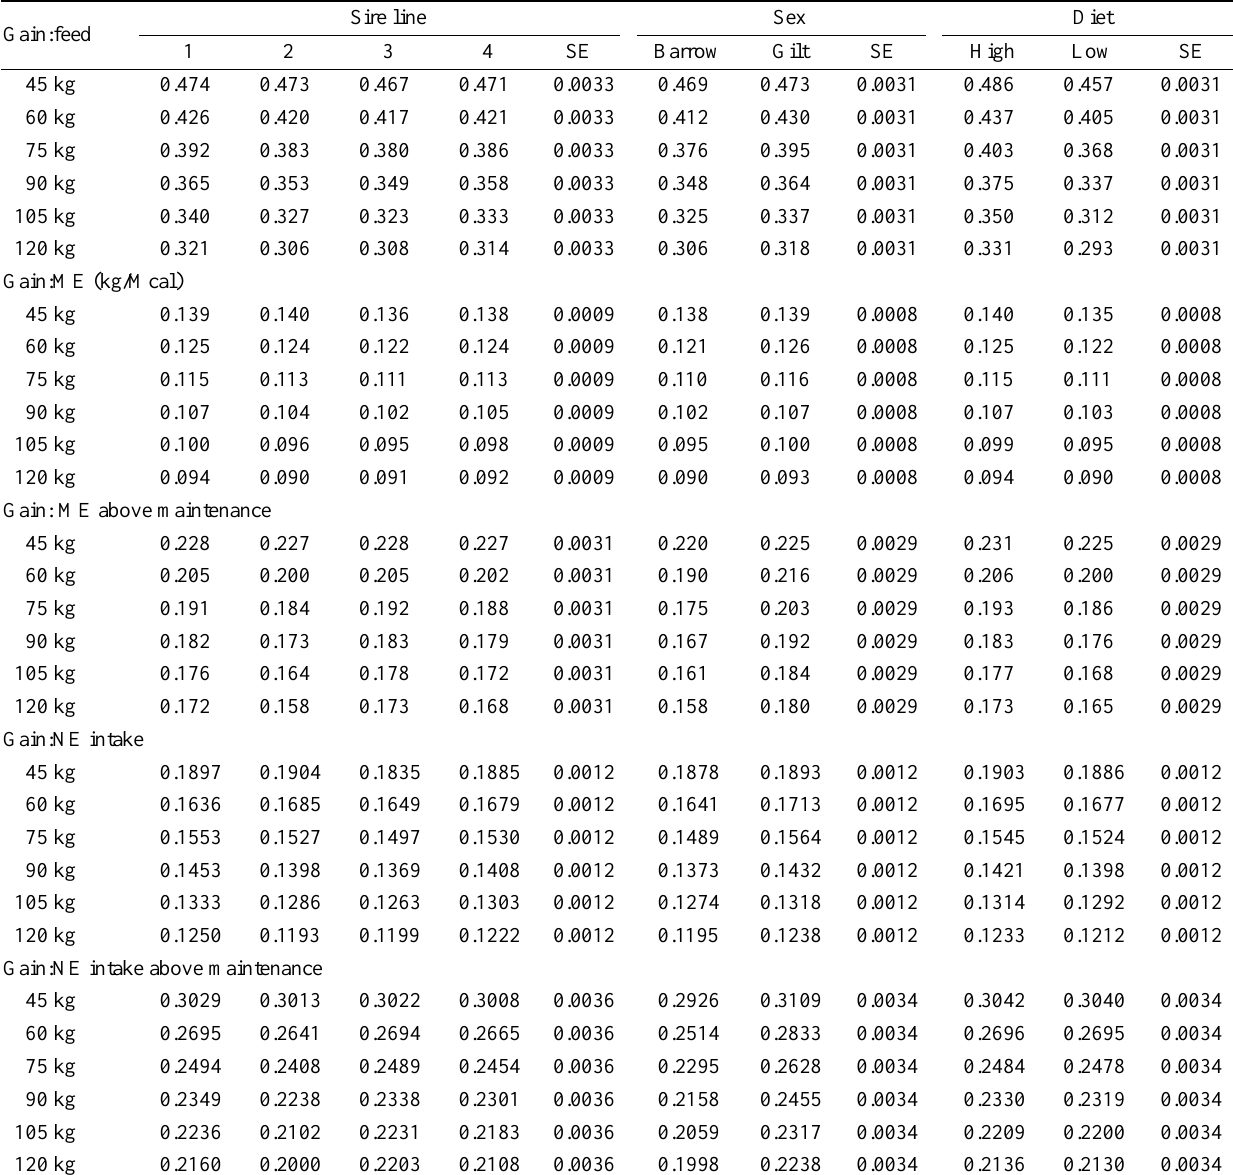
Table 12. Least-squares means for predicted gain:feed (kg/kg), gain:ME intake (kg/Mcal) and gain:ME intake above maintenance (kg/Mcal) at six BWs a